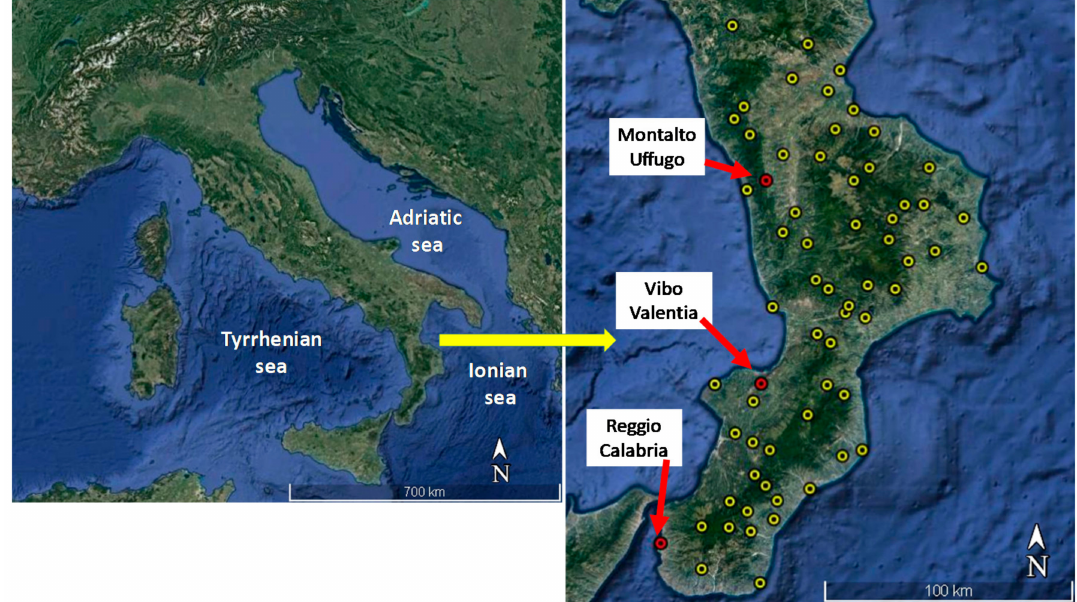
Figure 1. Location of the investigated rain gauges (yellow and red dots) in the Calabria region (southern Italy). The stations characterized by red dots (Montalto Uffugo, Reggio Calabria and Vibo Valentia) are described in detail in the present manuscript (see Section